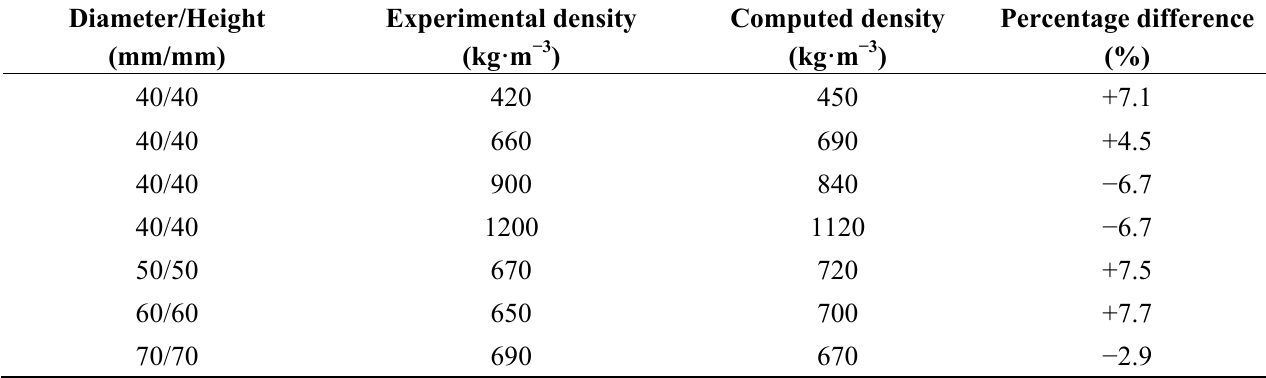
Table 2. Comparison for bulk and integrated density from the functional